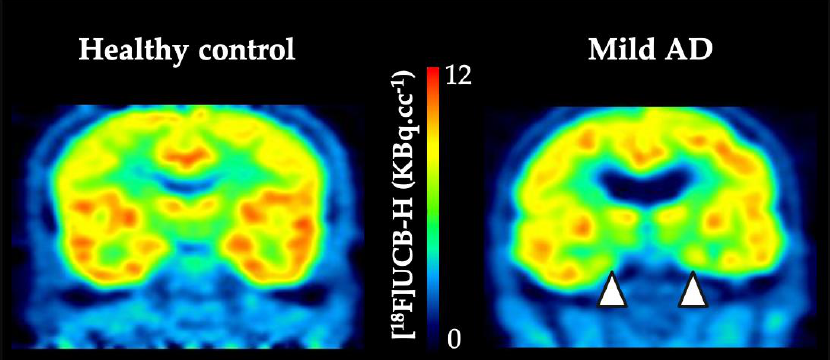
Figure 2. Individual example of [ 18 F]UCB-H in healthy control and in mild AD patient. The white arrow heads highlight the reduced [ 18 F]UCB-H uptake in temporal lobe areas of the mild AD